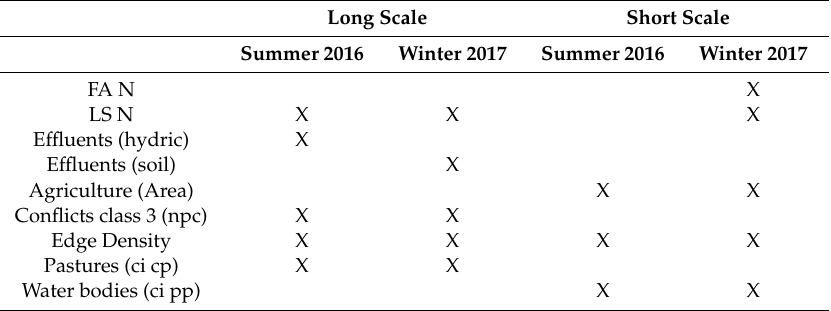
Table 3. Pressure e ff ects in ecological integrity, is marked with an x the season and scale were it was identified a negative e ff ect. Long